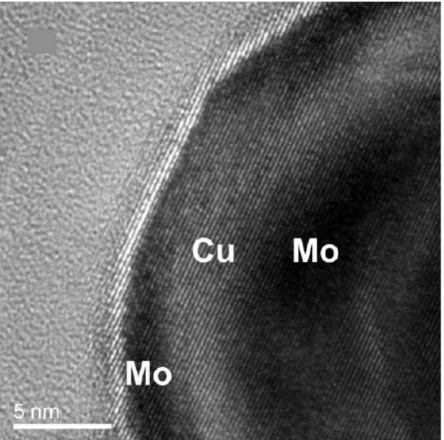
Figure 17. HRTEM image of a Mo@Cu@Mo nanoparticle produced by a segmented MoCu target in a sputter source. Reproduced from supplementary information to